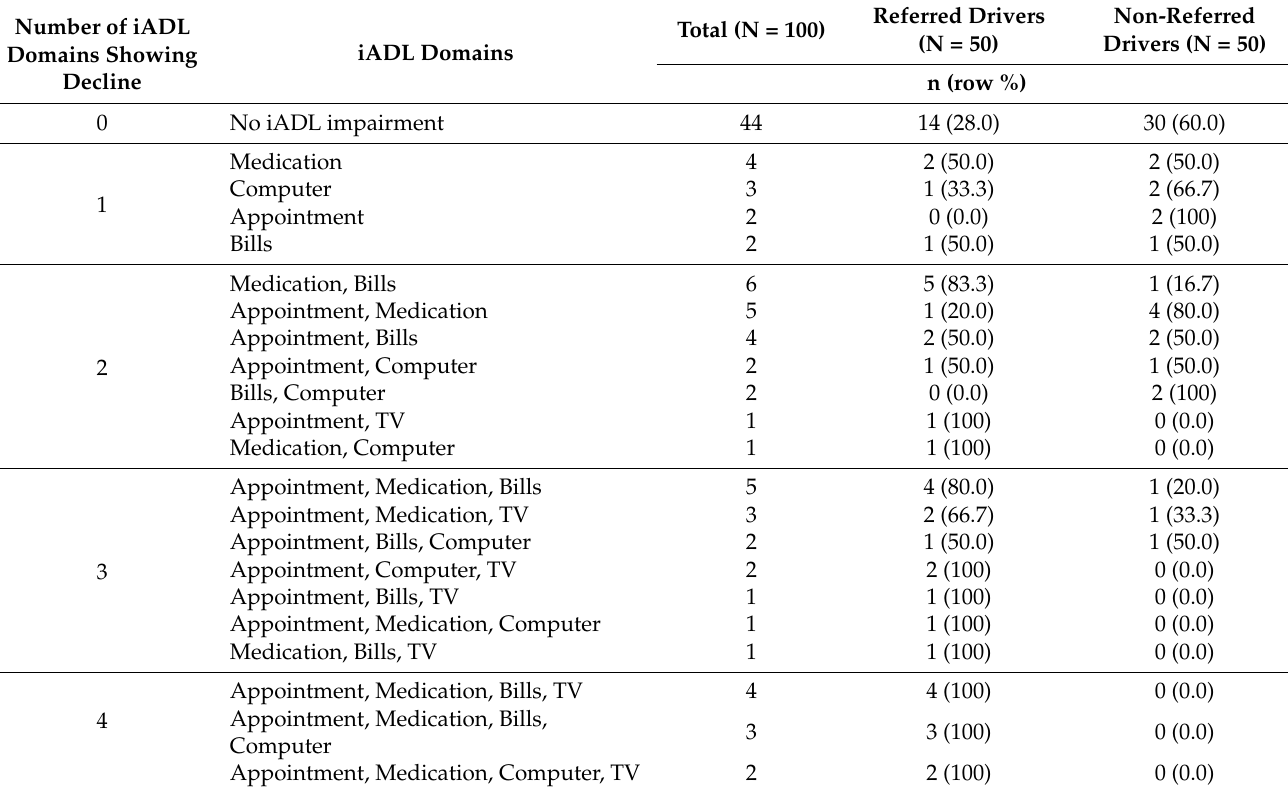
Table 4. Typology of iADL decline, stratified by referral status.